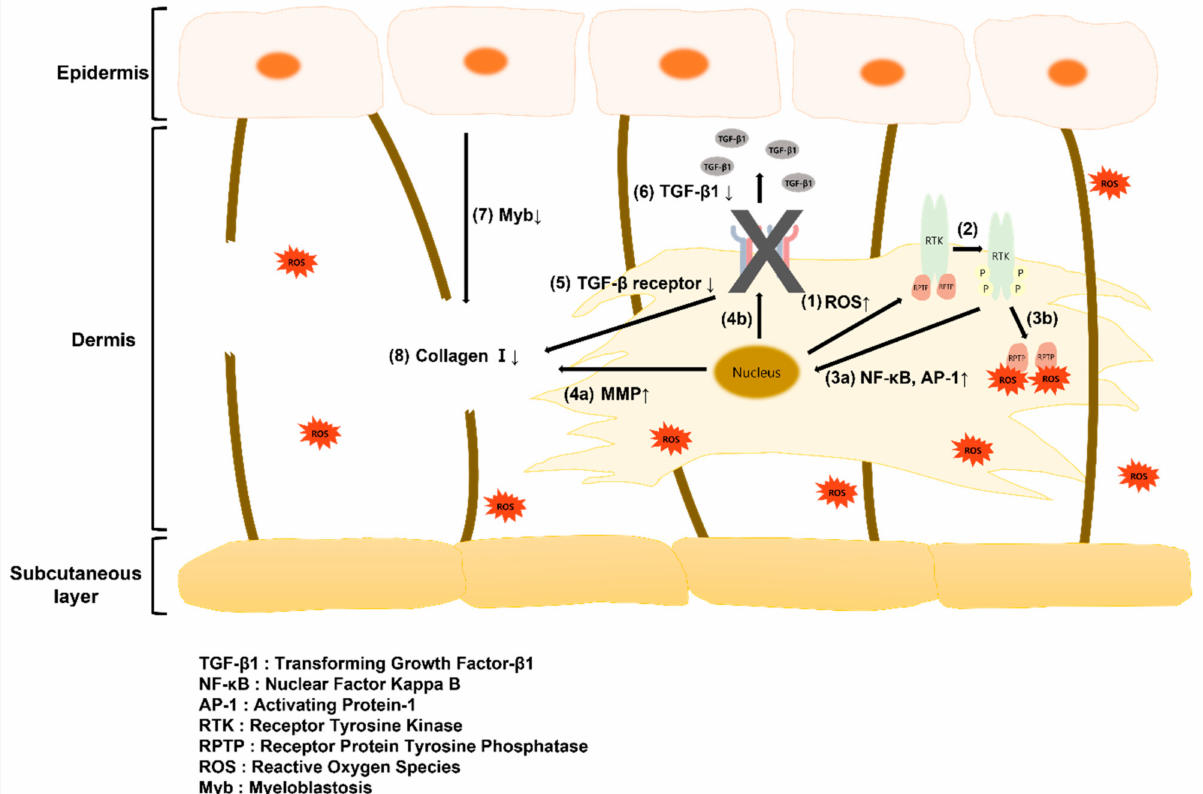
Figure 7. Schematic illustration of the paracrine signaling between fibroblasts and keratinocytes in the skin tissue: (1) Increase in ROS secretion from the nucleus by compressive stimulation; (2) RTK phosphorylation; (3a) increase in secretion of NF- κB and AP -1 delivered to the nucleus by phosphorylated RTK; (3b) RTK phosphorylation by binding of RPTP and ROS; (4a) Increase in MMP secretion from the nucleus; (4b) Signaling to decrease TGF- β receptor in the nucleus; (5) Decrease in TGF- β receptor ; (6) Decrease in TGF- β1 binding to TGF - β receptor ; (7) Decrease in Myb secretion; (8) Decrease in collagen I in the dermis layer. Three possible pathways for skin aging: (1) ➔ (2) ➔ (3a) ➔ (4a) ➔ (8), (1) ➔ (2) ➔ (3a) ➔ (4b) ➔ (5) ➔ (8), (1) ➔ (2) ➔ (3a) ➔ (4b) ➔ (5) ➔ (6) ➔ (7) ➔ (8).